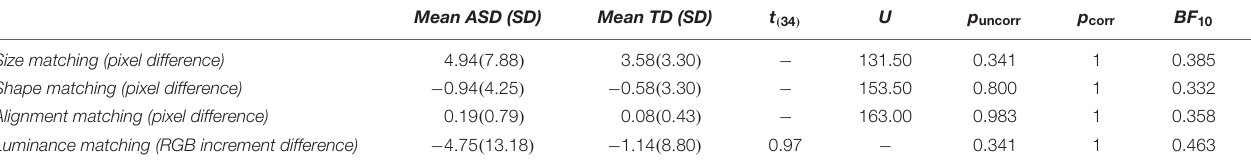
TABLE 2 | Performance on the control tasks in the ASD and TD